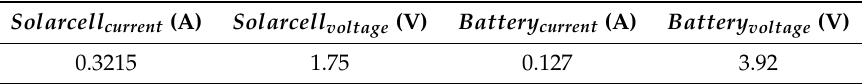
Table 7. Measurement during test of SAR as MPPT.